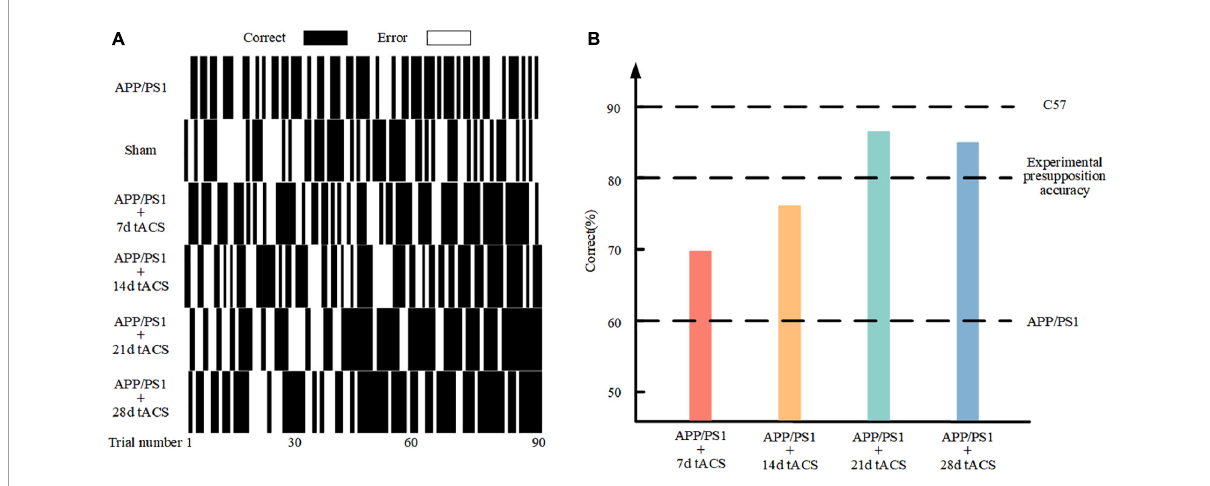
FIGURE4 (A) Behavioral results in the Y maze. (B) Comparison of 90 behavioral results in the different stimulation time groups.